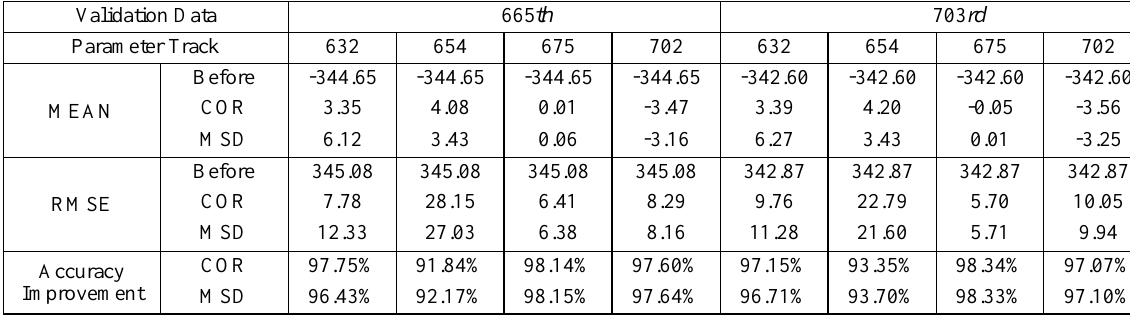
Table 3. Error statistics of 665 th and 703 rd original altimetry data before and after